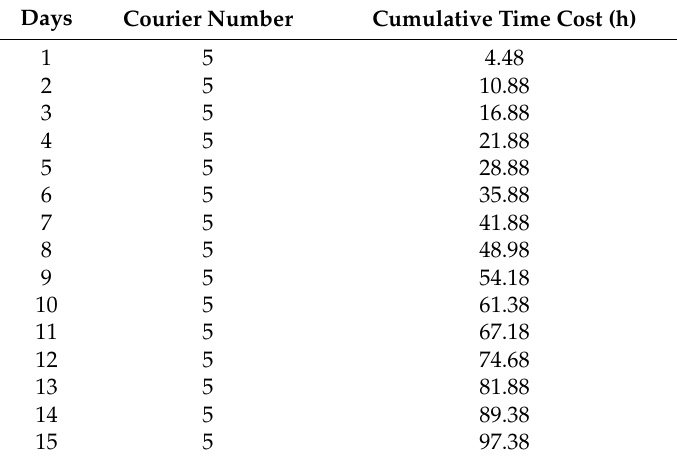
Table 7. Courier 5 cumulative time cost.